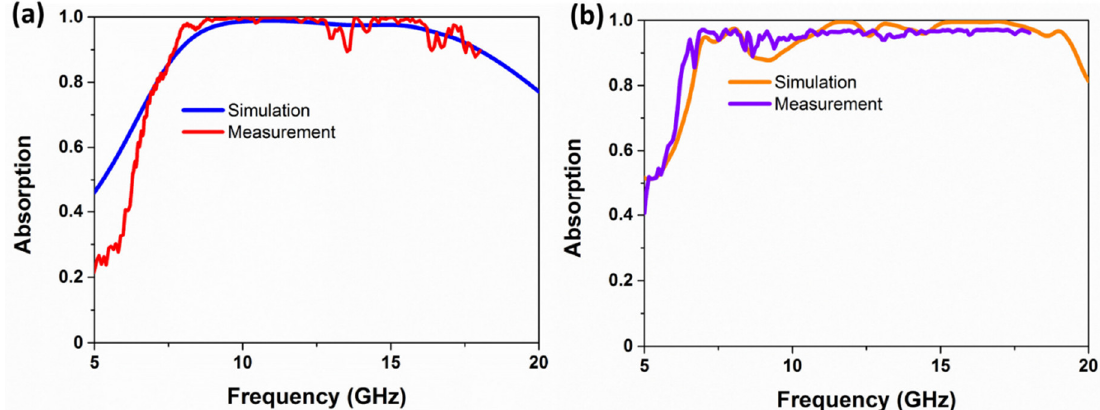
Figure 2. Simulated and measured absorption spectra of the ( a ) FBMPA and ( b ) BBMPA structure (a bending radius of 40